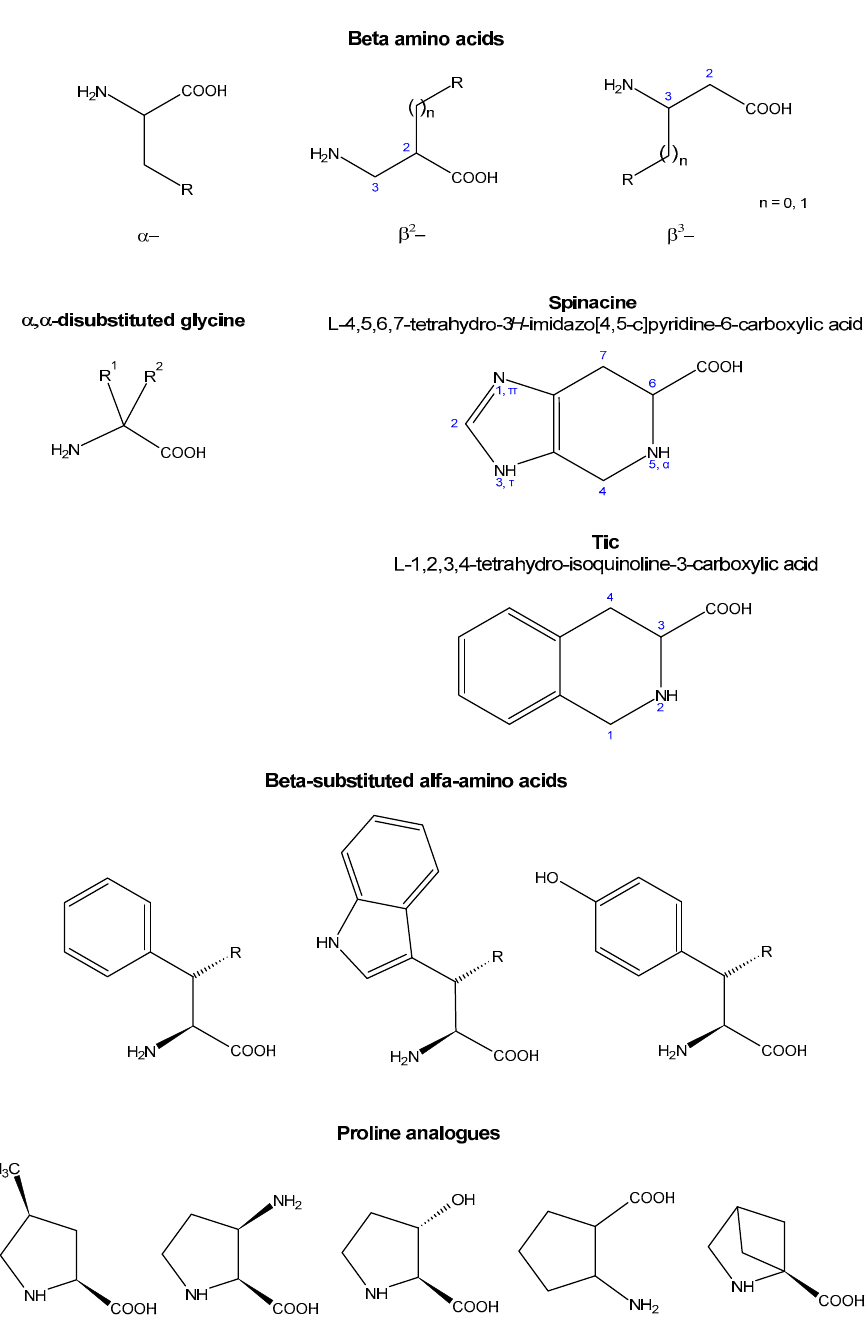
Figure 4. Some non-proteinogenic amino acids.